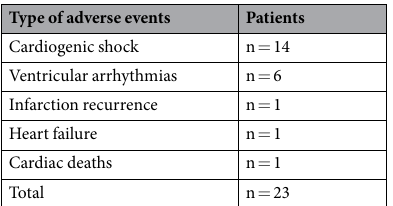
Table 2. Type of in-hospital Major adverse cardiac events.